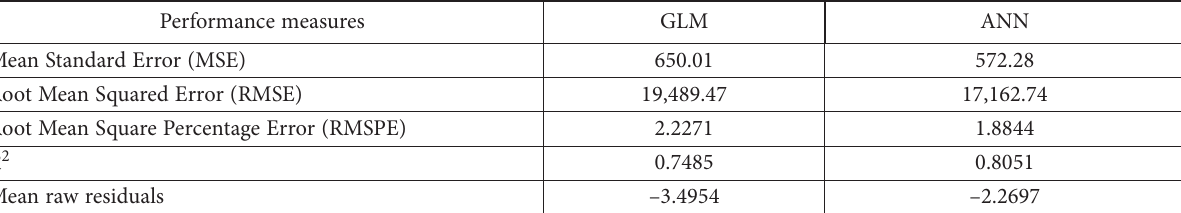
Figure 1. GLM and ANN prediction compared to observed selling price Table 9. Measures for GLM and ANN